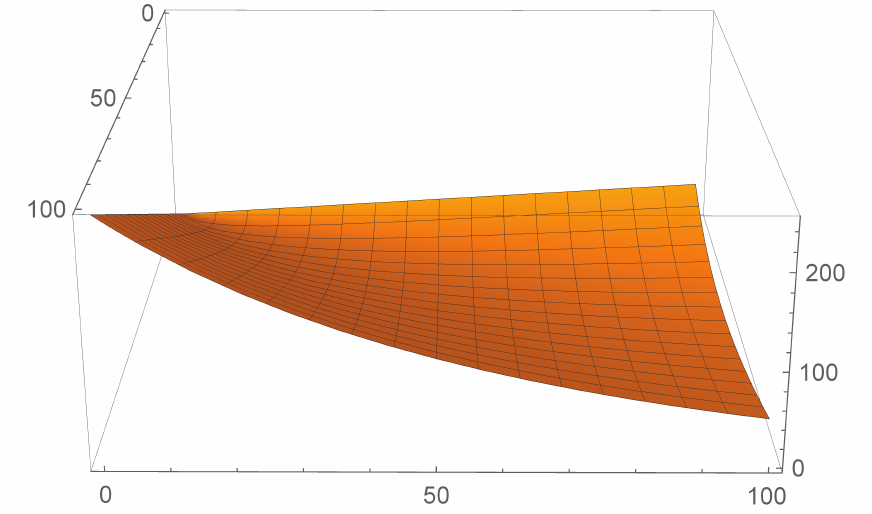
) with n SUB , n SUB 2 1